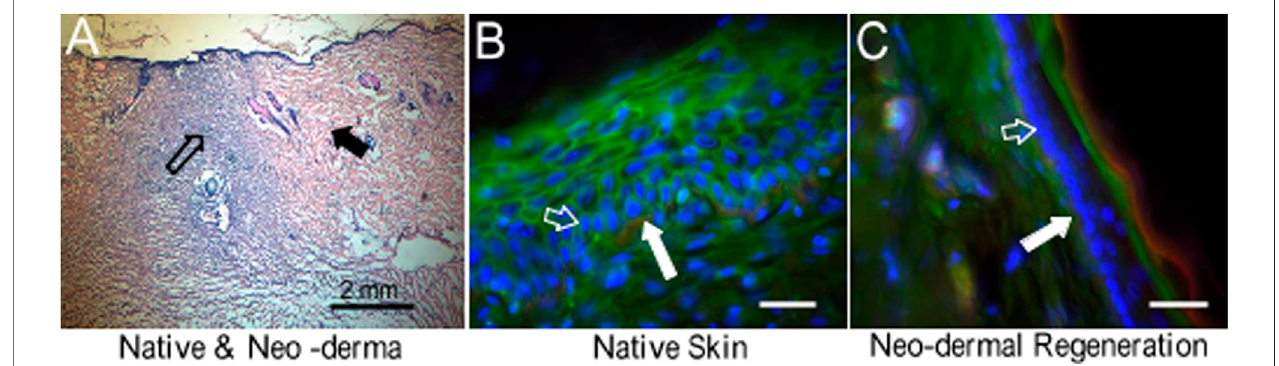
FIGURE 8 | HE staining and fl uorescence microscopic images to represent skin regeneration after the wound created in rats. (A) HE stain of neo-dermal regeneration(blackhollowarrow)andnativeskin(blacksolidarrow).Objective:×4. (B)N ativeskin. (C) Neo-dermalregeneration fi lledinthewound.Objective:×40.Red: green: sialic acid. Blue: nuclei. Collagen type IV. Bar: 50 μ m. White solid arrows indicate collagen type IV in the basal lamina. White hollow arrows indicate keratinocytes which were proliferating during skin